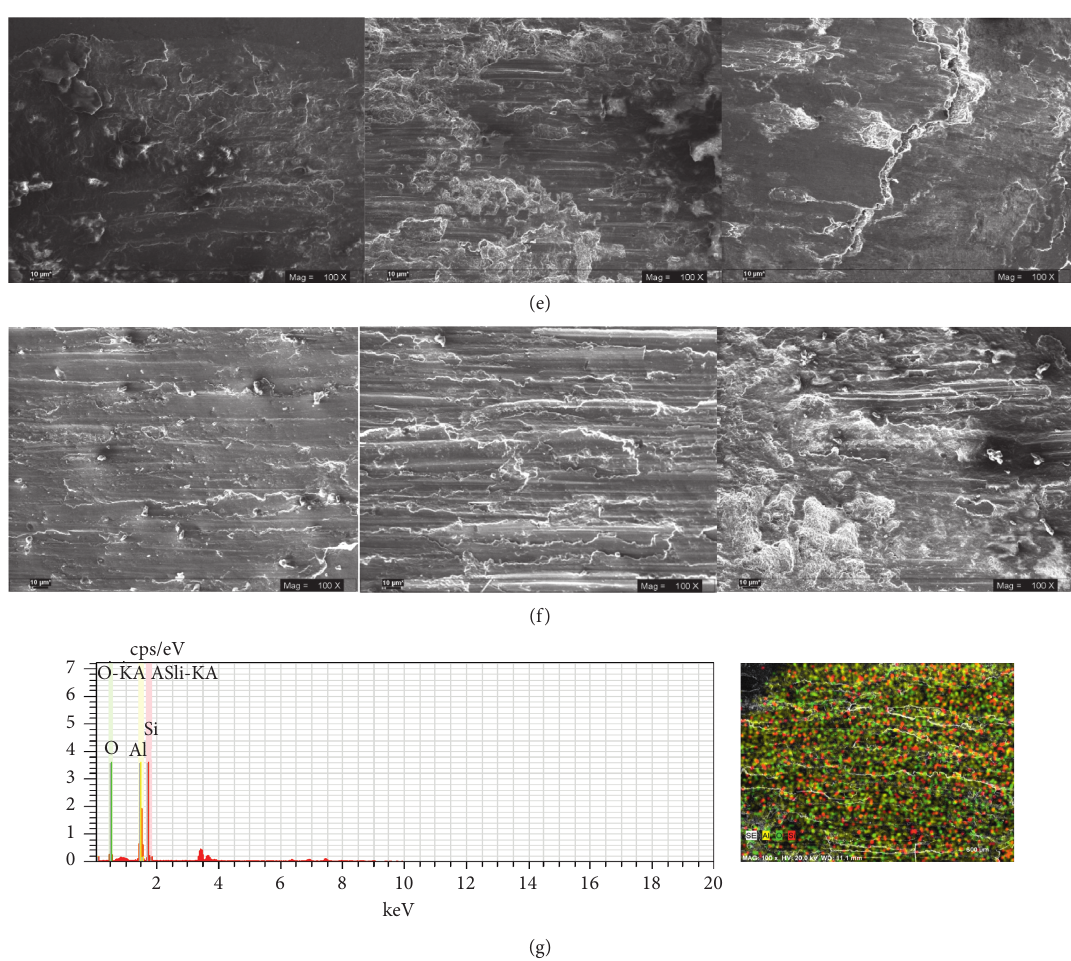
Figure 16: Wear scar observed under SEM and EDS analyses. (a) Base composition. (b) Composition 1. (c) Composition 2. (d) Composition 3. (e) Composition 4. (f) Composition